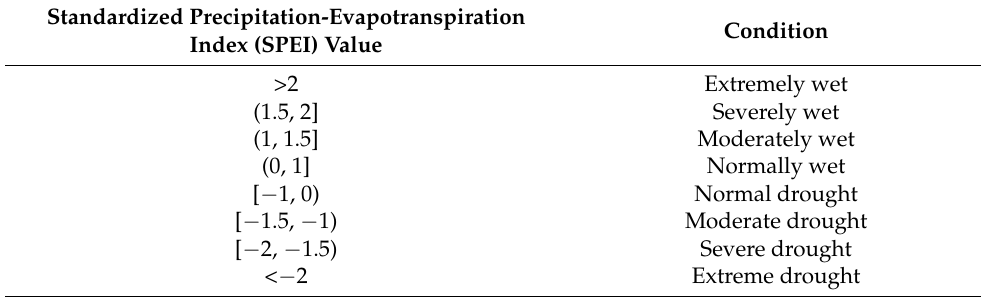
Table 1. Thresholds of Standardized Precipitation-Evapotranspiration Index (SPEI) values for water